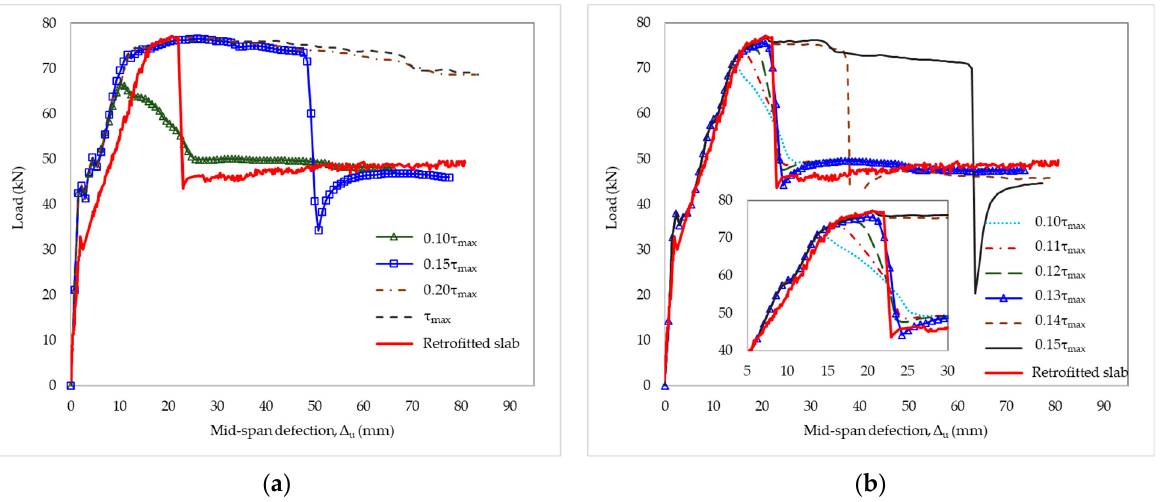
Figure 14. Sensitive to the maximum shear stress ( a ) initial stiffness of K 0 ; ( b ) initial stiffness of 0.1K 0 . According to the simulations, the delamination loads were 66.2 kN and 74 kN, corre ‐ sponding to 10.1 mm and 48 mm of the mid ‐ span deflection, respectively, occurring with the maximum shear stresses of 0.1 τ max and 0.15 τ max , respectively. The numerical results also indicated that the debonding failure emerged earlier, at 0.1 τ max and later at 0.15 τ max , compared with the experimental results. Moreover, the overestimation of the initial stiff ‐ ness should also be highlighted in this case. The maximum shear stress ranged from 0.1 τ max to 0.15 τ max , combined with the initial stiffness of 0.1K 0 ; thus, the case was further evaluated. The delamination load and mid-span deflection of the retrofitted slab increased with the increase in the maximum shear stress but was not proportional; however, there were no notable differences in the delamination load after the yield in steel. The global response of the strengthened slab was displayed as a function of the shear stress values. As a result, it was possible to reasonably simulate the behavior of the retrofitted slab and compare it with its experimental counterpart with the initial stiffness of 0.1K 0 and maximum shear stress of 0.13 τ max , as shown in Figure 14b. In this part of the study, we analyzed the damage initiation criteria as the quadratic and maximum nominal stresses based on the proposed results mentioned above. The quadratic stress criterion is defined by accounting for the effect of traction components, while the maximum stress criterion is established by comparing the traction components to their respective allowable values [54].